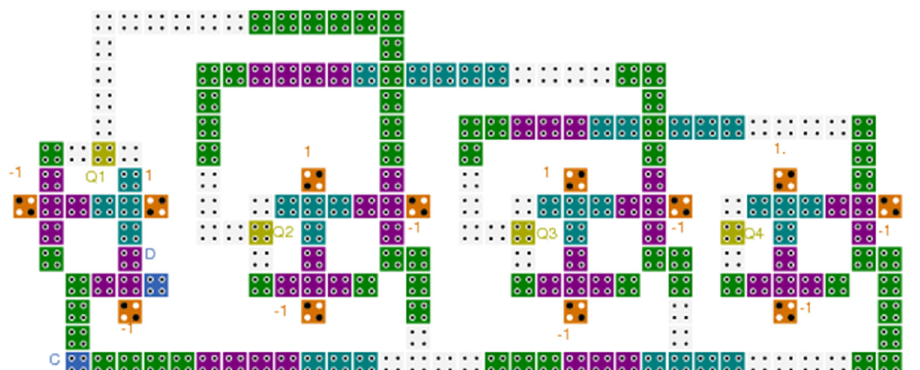
Figure 19. Simulation Graph of 3-bit SIPO shift register.